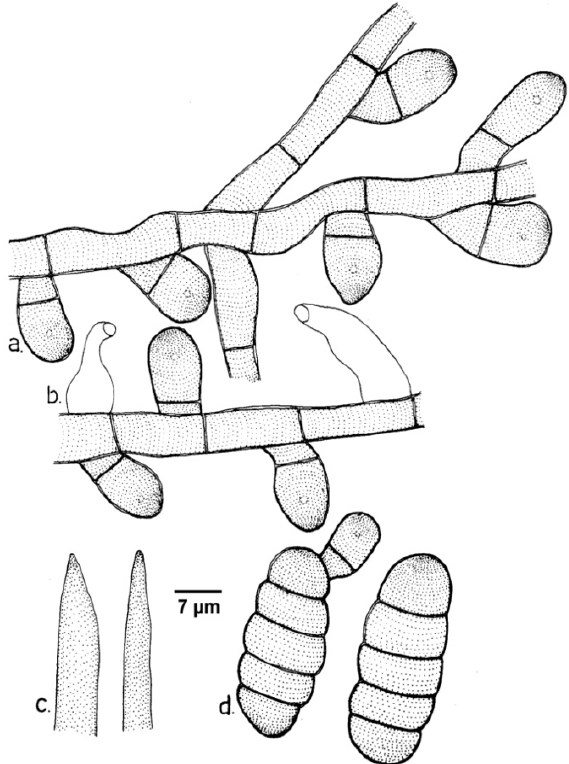
Figure 72. Meliola erythropali a - Appressorium; b - Phialide; c - Apical portion of mycelial setae;